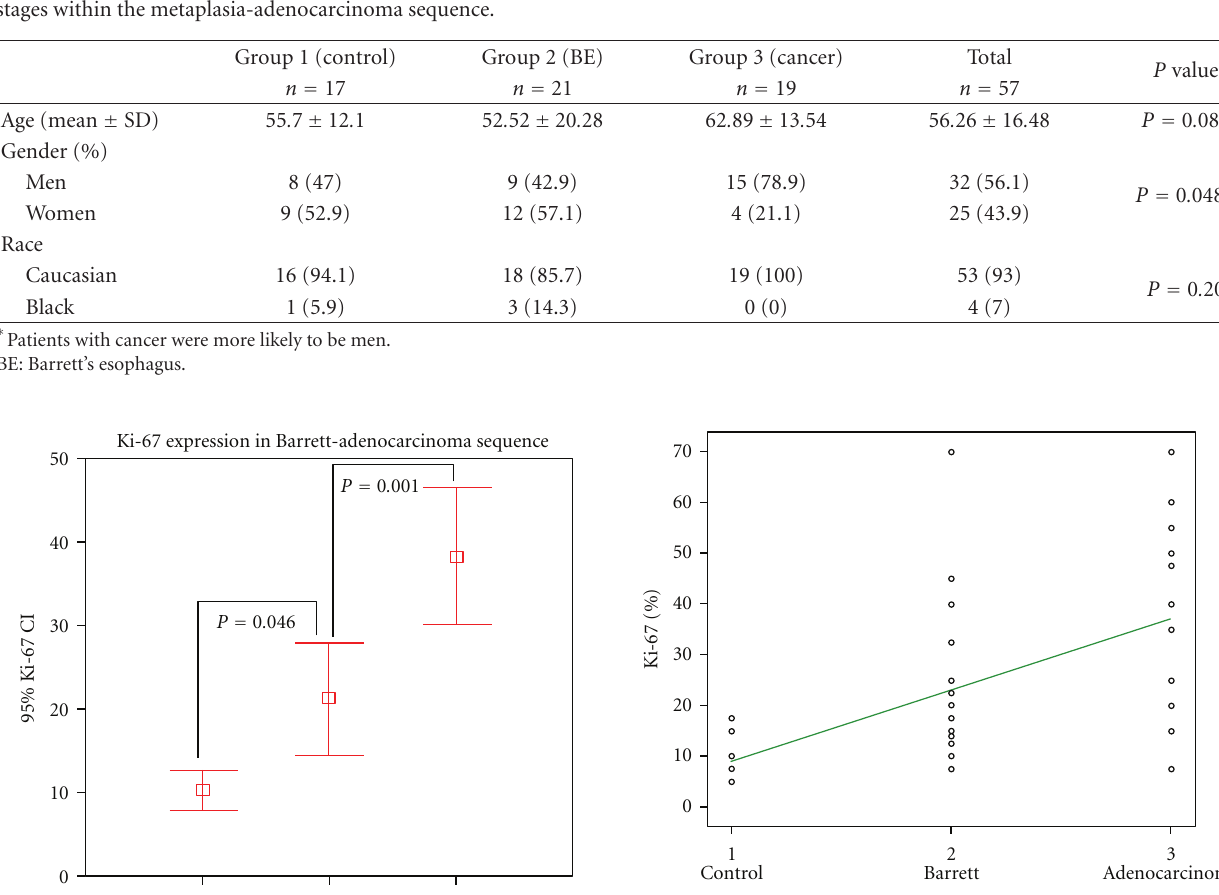
Figure 6: The correlation between Ki-67 antigen and the Barrett’s esophagus to adenocarcinoma sequence. Pearson coe ffi cient = 0.6 ( P < 0 .